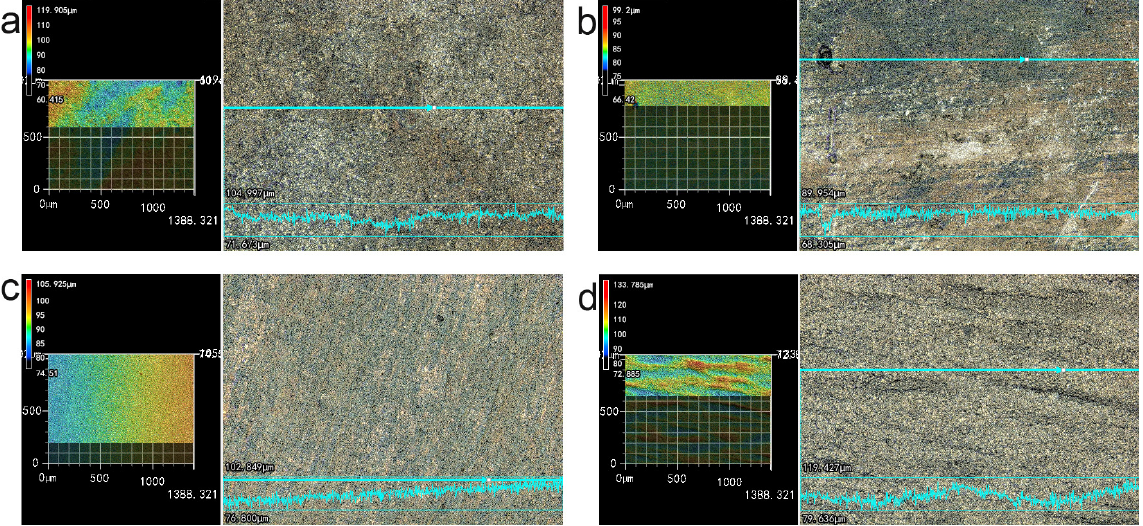
Figure 7. 3D profilometry of casing steel after exposed in residual acid solutions with or without Mb inhibitor for 4 h at 90 °C: ( a ) pH 1.0; ( b ) pH 1.0 + Mb; ( c ) pH 3.0; ( d ) pH 3.0 + Mb.